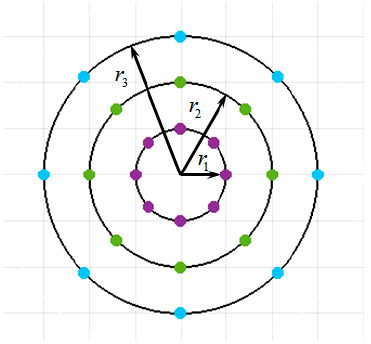
Figure 3. An example of the first implementation of a 3-scale CLBP operator ( m “ 8, r 1 “ 1 , r 2 “ 2 , and r 3 “ 3 ).